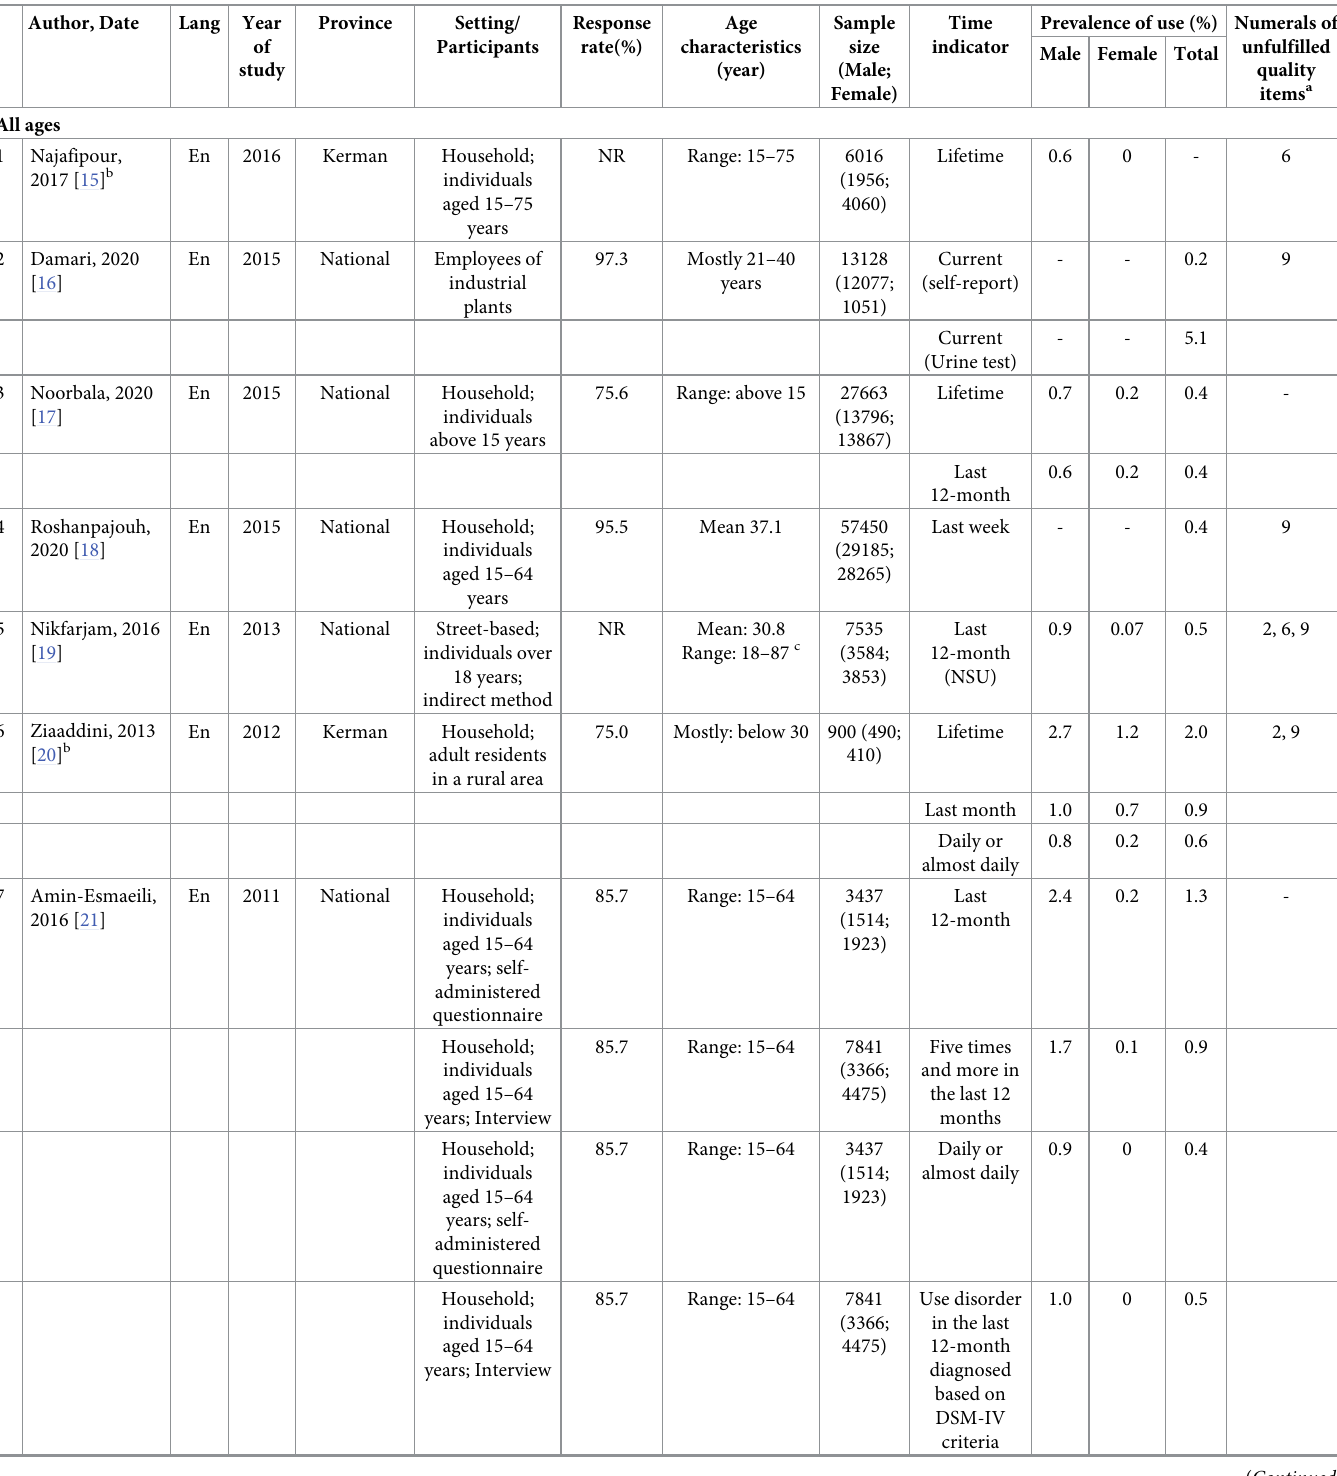
Table 1. Characteristics and results of studies on the prevalence of cannabis use and use disorder among the general